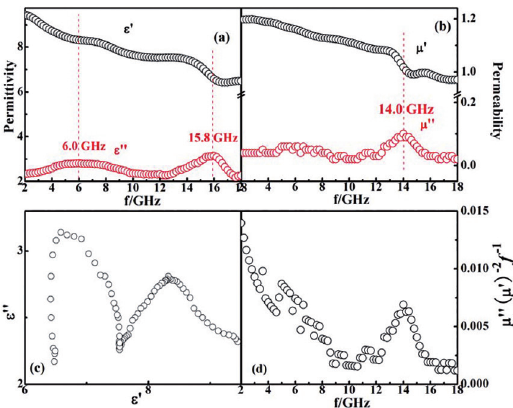
Figure 3: (a) Relative permittivity and (b) relative permeability of FeNi/SnO nanocapsules-paraffin composite as a function of frequency; (c) Typical Cole-Cole semicircles for the composite; (d) Values of μ ’’( μ ’) -2 f -1 for the composite as a function of frequency.